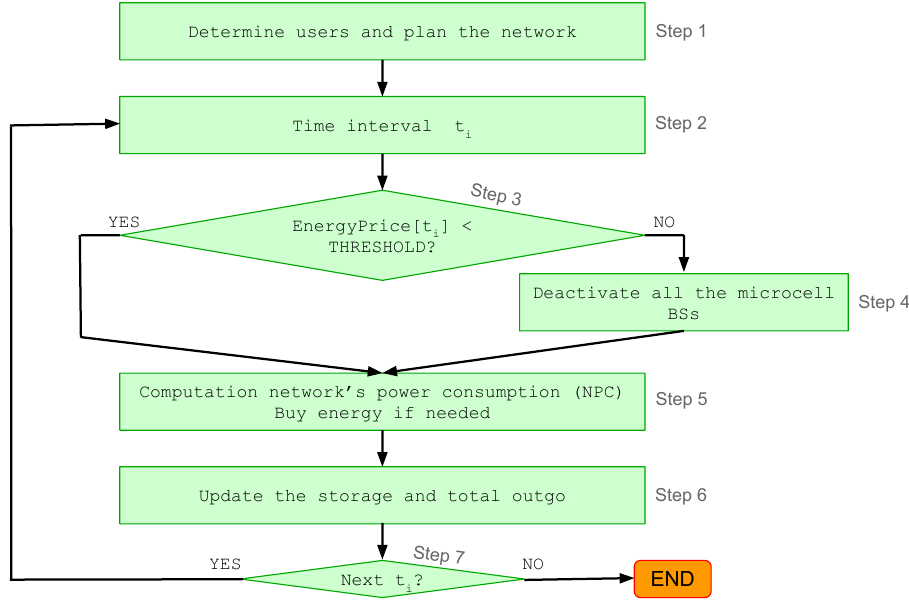
Figure 5. Flow chart when using the Take action according to the energy price